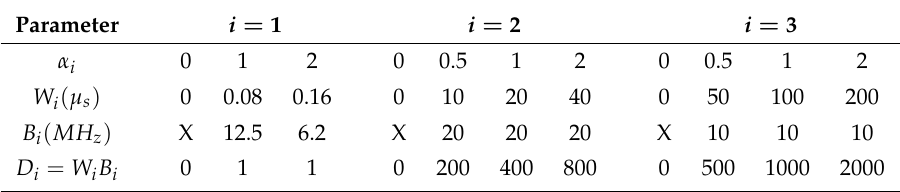
Table 2. The signal waveform parameters and effects implemented under various control parameters.